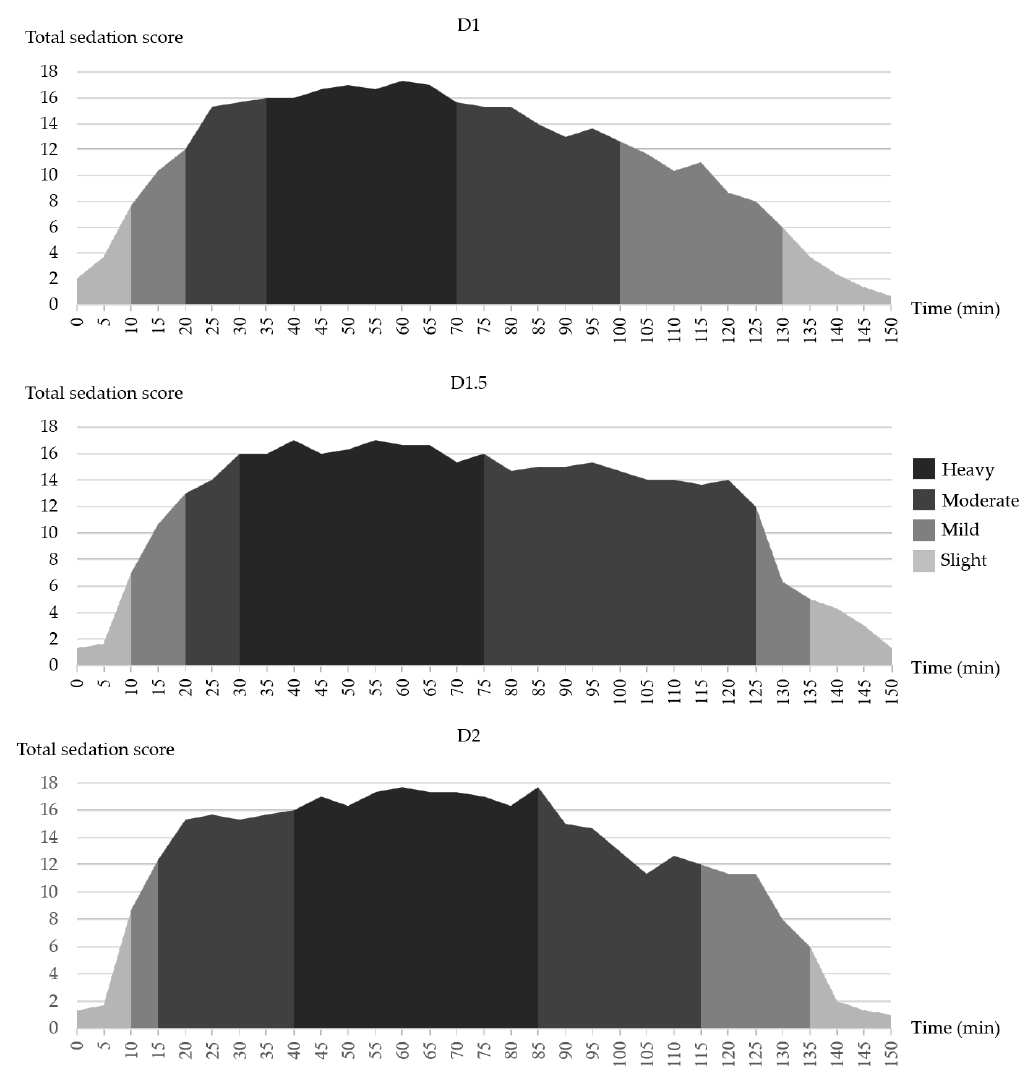
Figure 2. Area charts indicated an average sedation score and sedation level of groups D1, D1.5 and D2 at various time points . The sedation score was divided into four levels, including slight ( scores